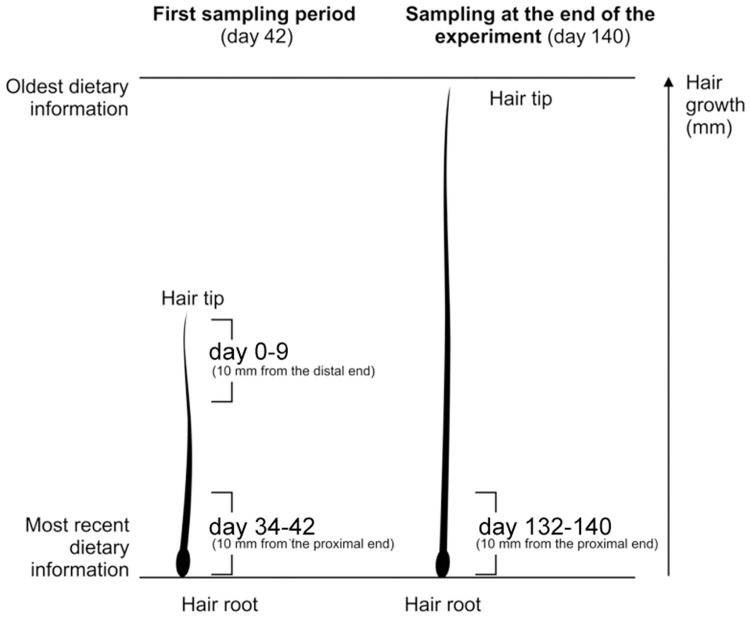
Sequences of wild boar hair used for isotope analysis of δ13C and δ15N.The wild boar hair were collected at the first sampling period (day 42) and at the end of the experiment (day 140) from the shoulder and rump of each wild boar.